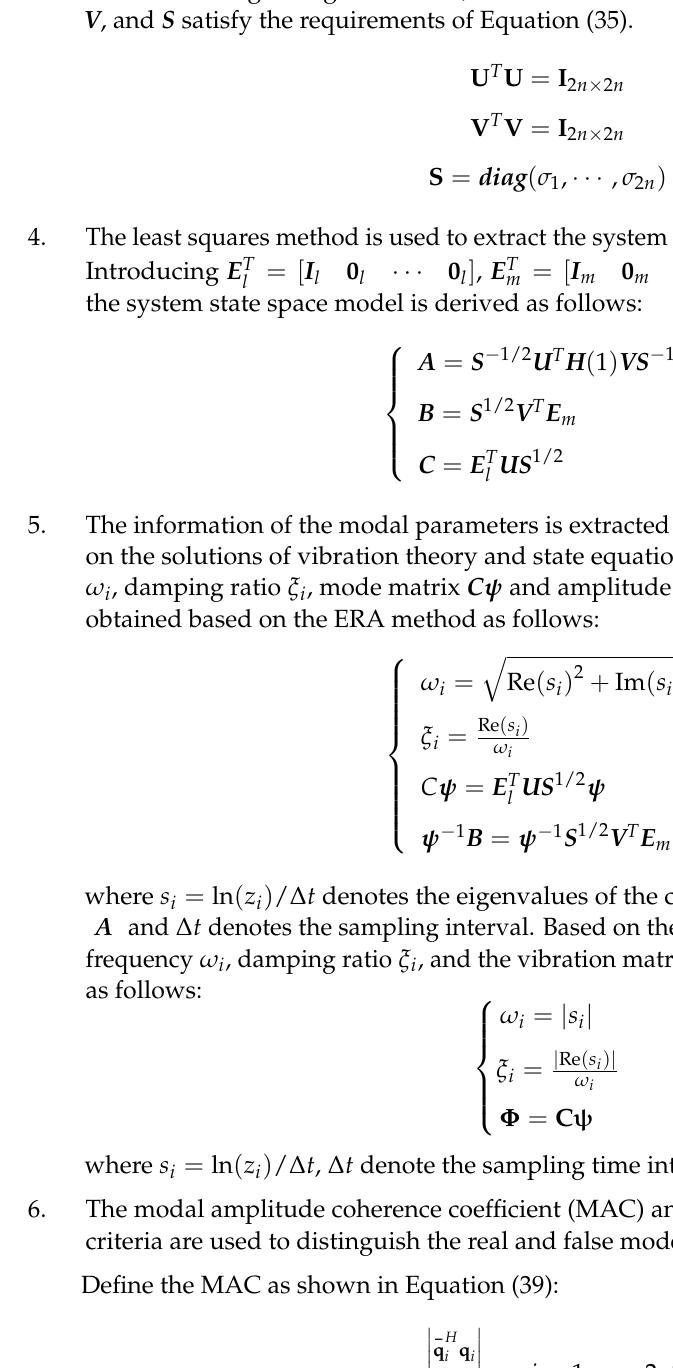
6. The modal amplitude coherence coefficient (MAC) and modal singular value (MSV) criteria are used to distinguish the real and false